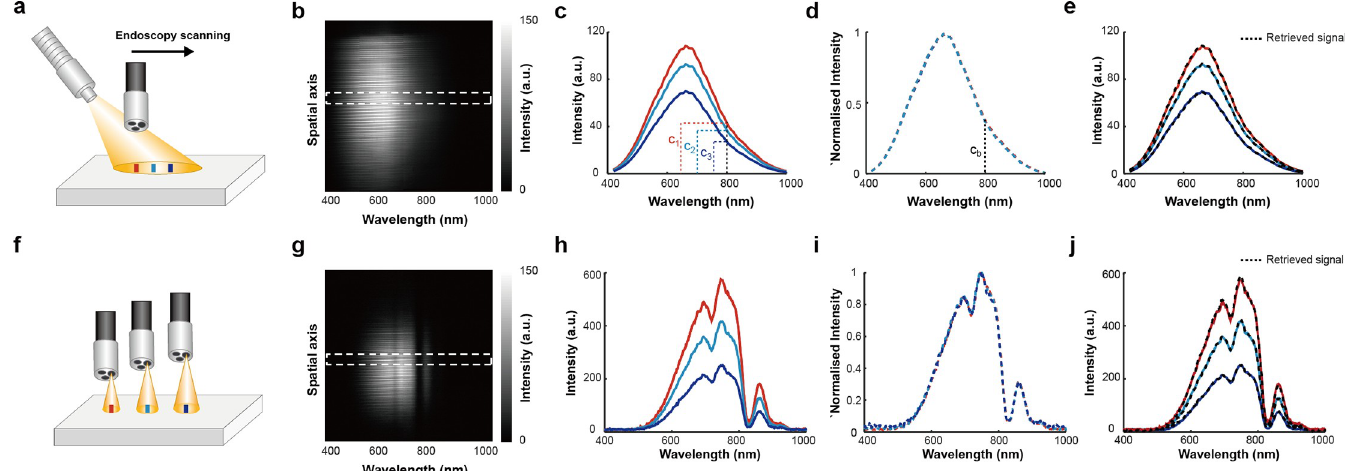
Fig 2. Spectral profiles of different illumination conditions can be accurately retrieved through hyperspectral endoscopy by different illumination methods. (a) Schematic of the external illumination methods. Red, green, and blue lines indicate the hyperspectral imaging regions. (b) Representative spectral image from the hyperspectral endoscope during external illumination. (c) Average spectral signals of the three hyperspectral images measured at the different locations shown in (a) obtained from the white-dashed region in (b). (d) Min-max normalisation of spectral signals in (c) show complete overlap. (e) Spectra obtained (black dashed lines) using the normalised spectral profile in (d) and ratio of values at 800 nm (c 1 , c 2 , c 3 , and c b ). (f-j) As above but for the internal illumination method.